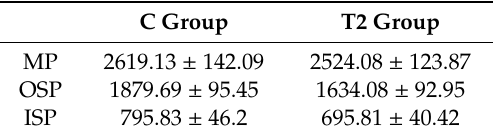
Table 2. Size [ µ m 2 ] of the MP—myenteric plexus, OSP—outer submucous plexus, and ISP—inner submucous plexus in porcine duodenum under physiological conditions (C group) and after administration of T2